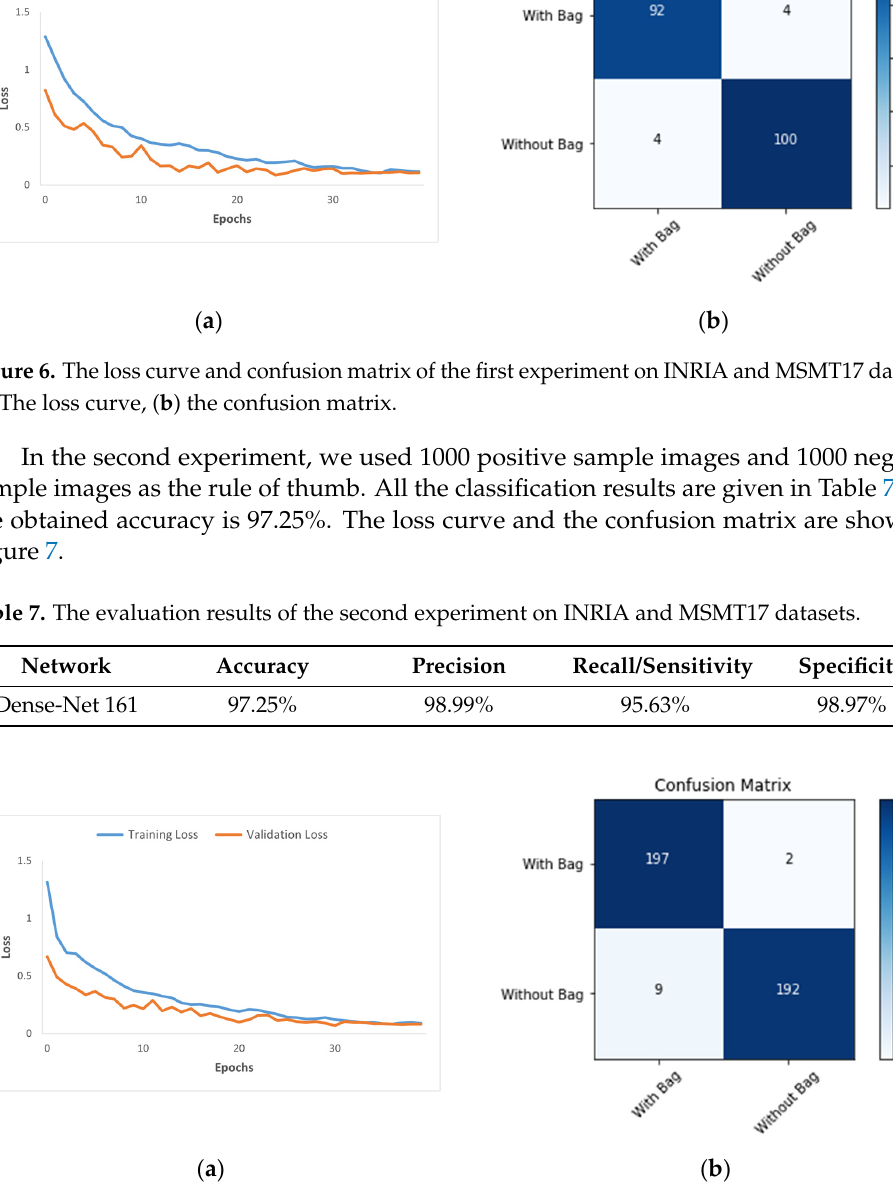
Table 6. The evaluation results of the first experiment on INRIA and MSMT17 datasets. Network